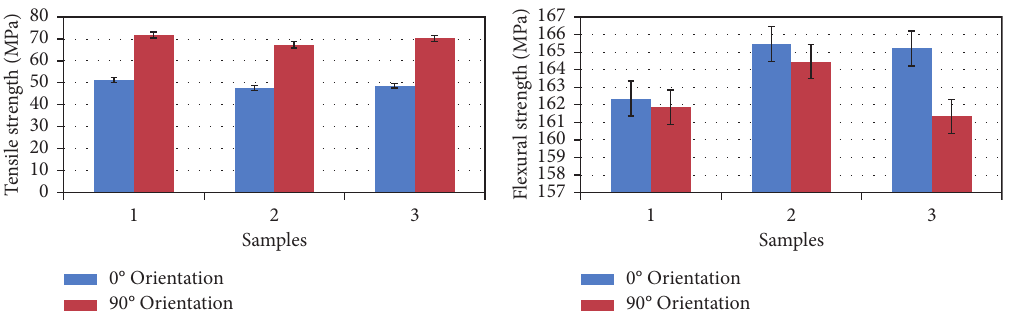
Figure 4: Effect of fibre orientation on tensile and flexural strengths of kenaf/glass fibre hybrid composites